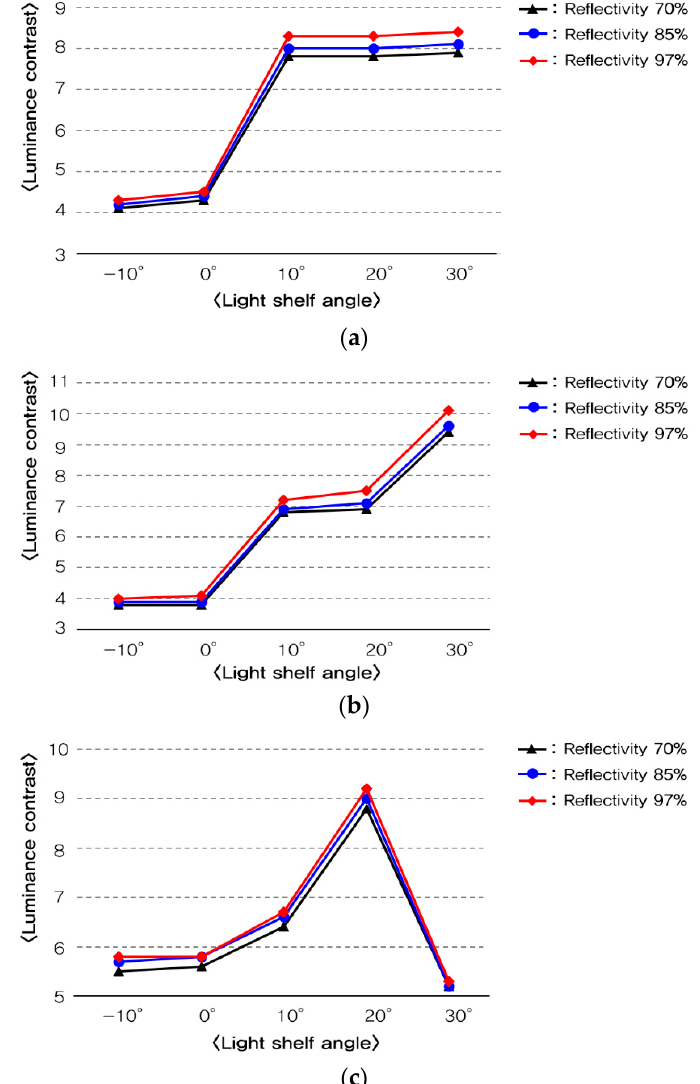
Figure 11. Analysis of luminance contrast per light shelf angle and reflectivity: ( a ) luminance contrast per light shelf angle and reflectivity in summer; ( b ) luminance contrast per light shelf angle and reflectivity in middle season; ( c ) luminance contrast per light shelf angle and reflectivity in winter. Table 11 Analysis of light shelf variables and lighting energy consumption to improve energy saving and visual environment.